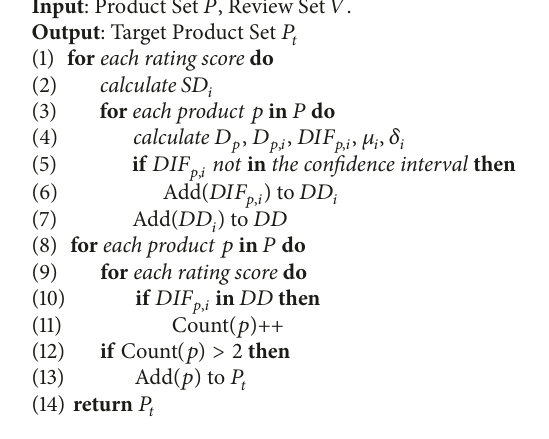
Table 3: Metapath results.